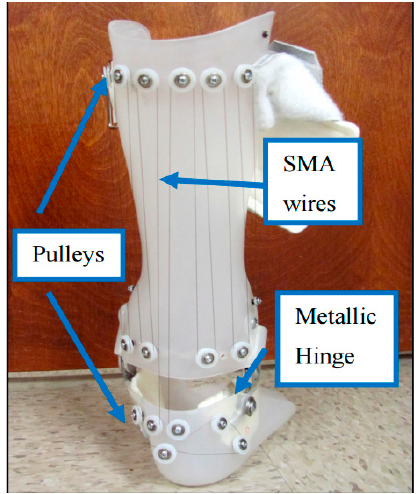
Figure 18. Pulley arrangement on hinged AFO to attach SMA wires [49].